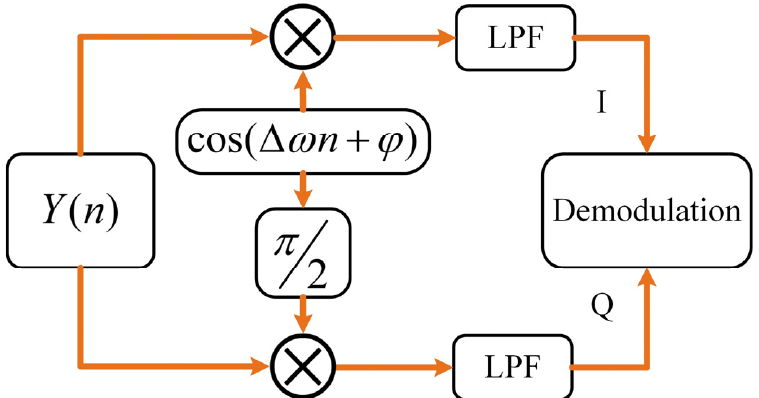
Figure 5. Digital I / Q demodulation process, LPF: low pass filter. Figure 5. Digital I/Q demodulation process, LPF: low pass